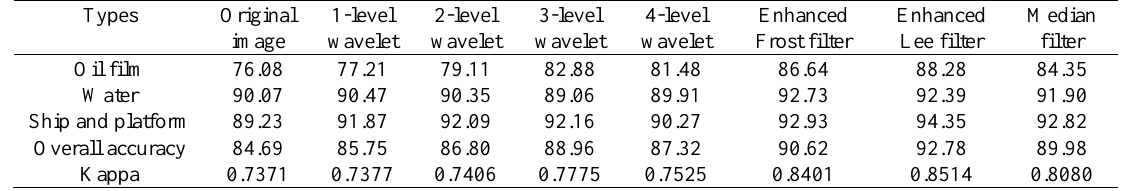
Table 1. SVM detection accuracy of different flare suppression method